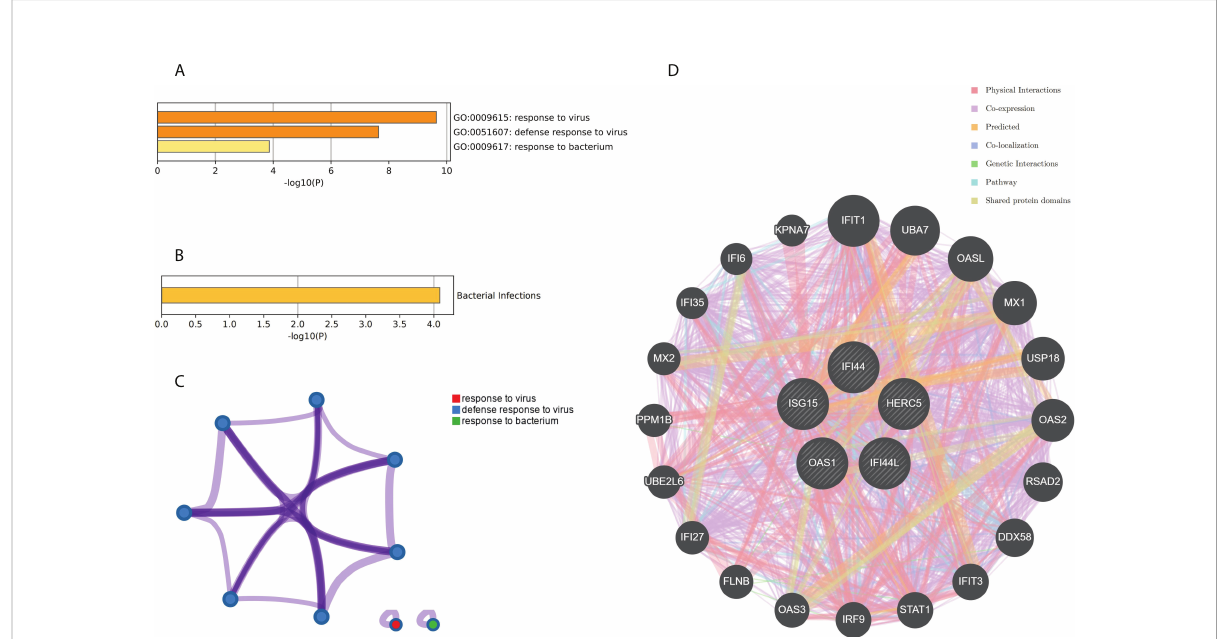
FIGURE 9 Functional enrichment analysis: Metascape and GeneMANIA of fi ve hub genes. (A) Pathway and process richness analysis of the Metascape platform. (B) Summary of enrichment analysis of DisGeNET 13 on Metascape platform. (C) The network is visualized using Cytoscape 5 , colored by cluster IDs, and nodes sharing the same cluster ID are usually close to each other. (D) The gene – gene interaction network of the fi ve hub genes with the 20 most adjacent genes was analyzed using the GeneMANIA database. Each node represents a gene. The color of the linkage of the nodes represents the linkage between the corresponding